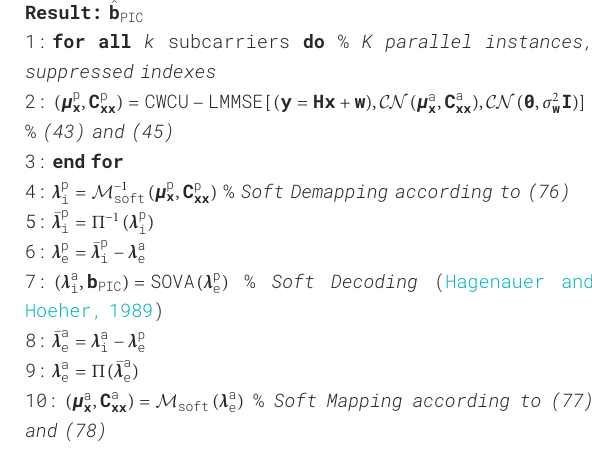
Algorithm 5. Genie-Aided